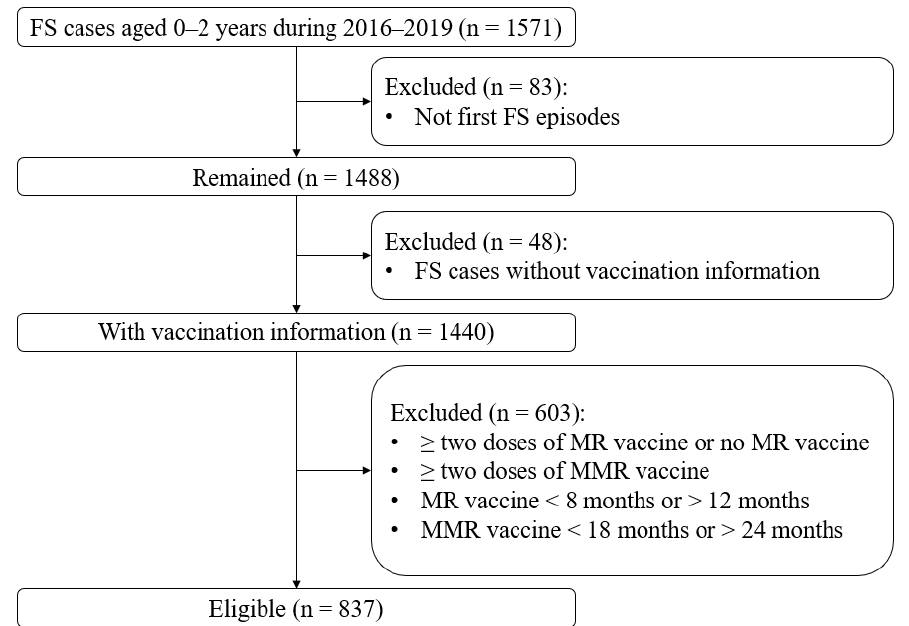
Figure 1. Flowchart of the study participants. Abbreviations: FSs, febrile seizures; MMR, measles- mumps-rubella; MR, measles-rubella. Table 1. Characteristics of the children with FSs included in this study.